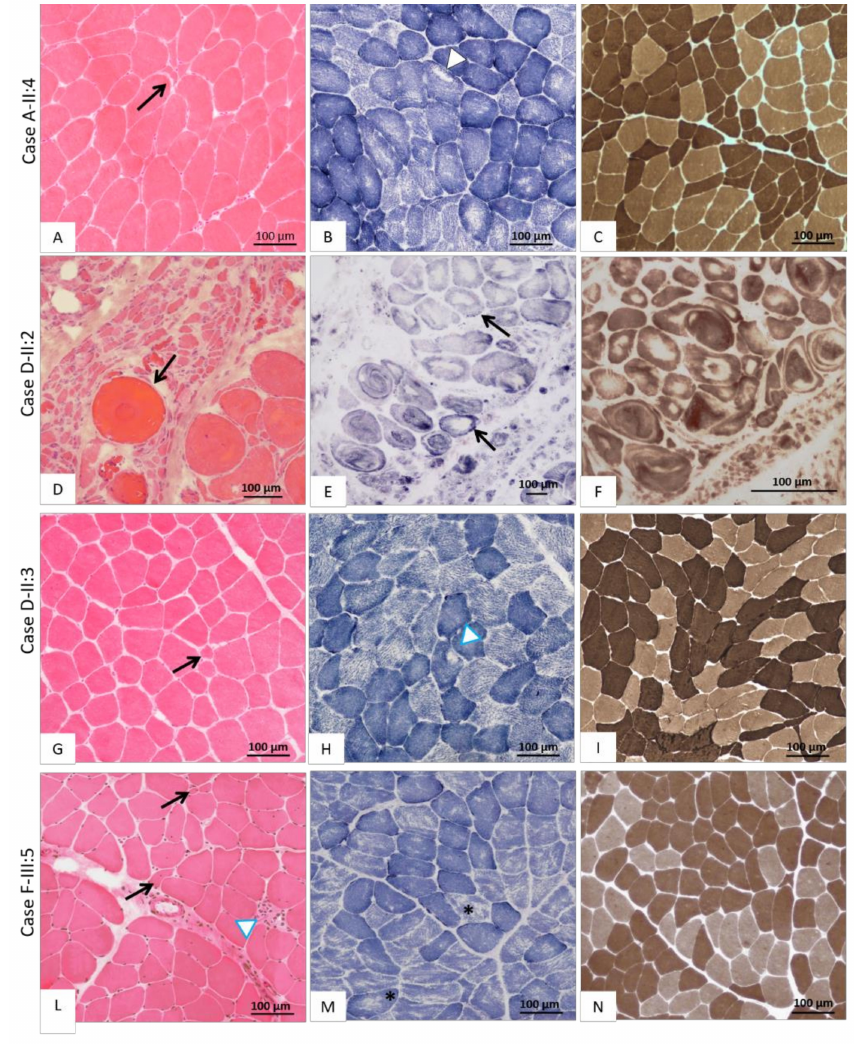
Figure 3. Histological findings on muscle biopsy. The first column shows images of muscle stained with haematoxylin-eosin (H&E), the second with succinate dehydrogenase (SDH) and the third